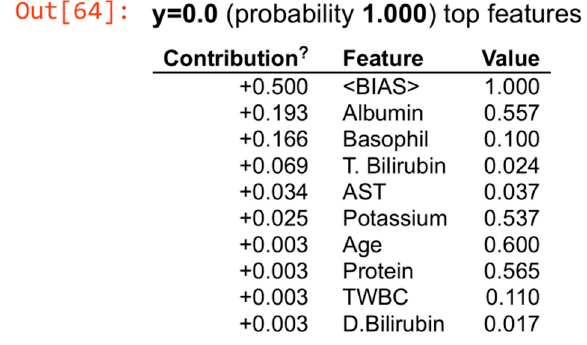
Figure 12. Eli5 model to understand model predictions.